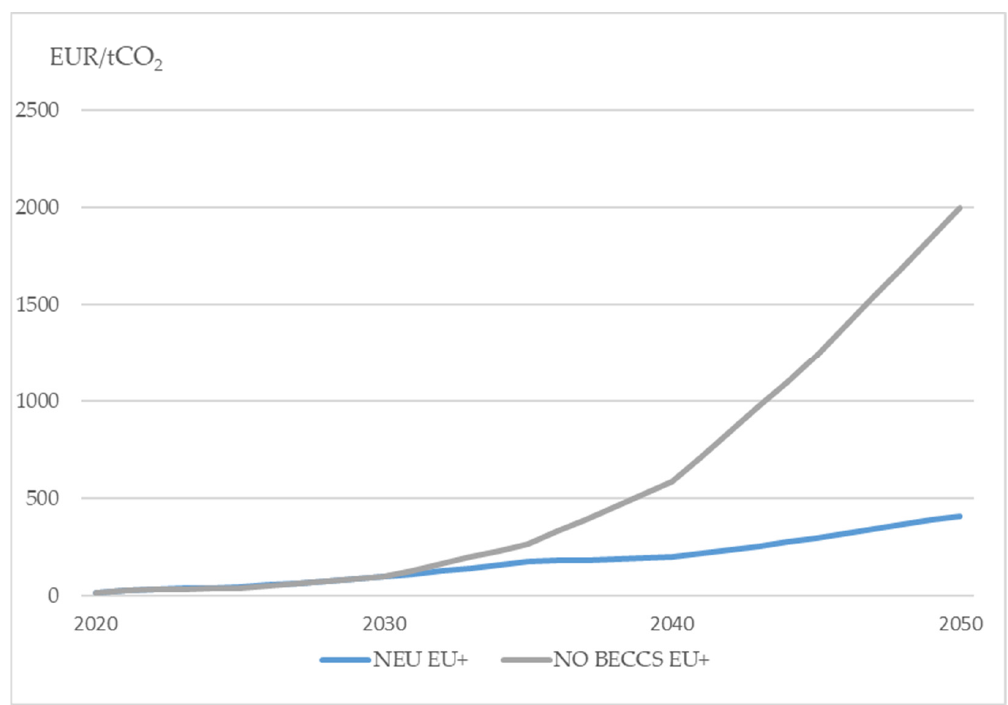
Figure 9. CO 2 price in the EU+ (in EUR/tCO 2 ). Source: own calculations based on MEESA and d-PLACE models.